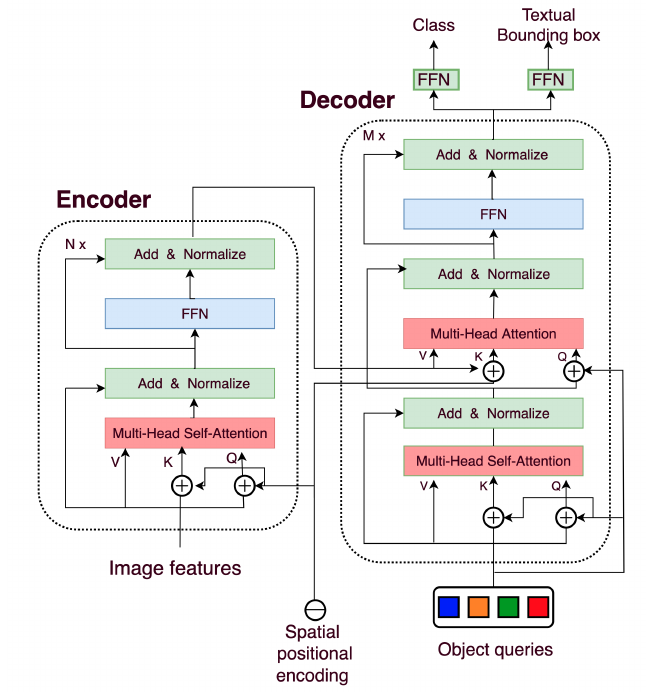
Figure 2. Detailed DETR transformer architecture as presented in